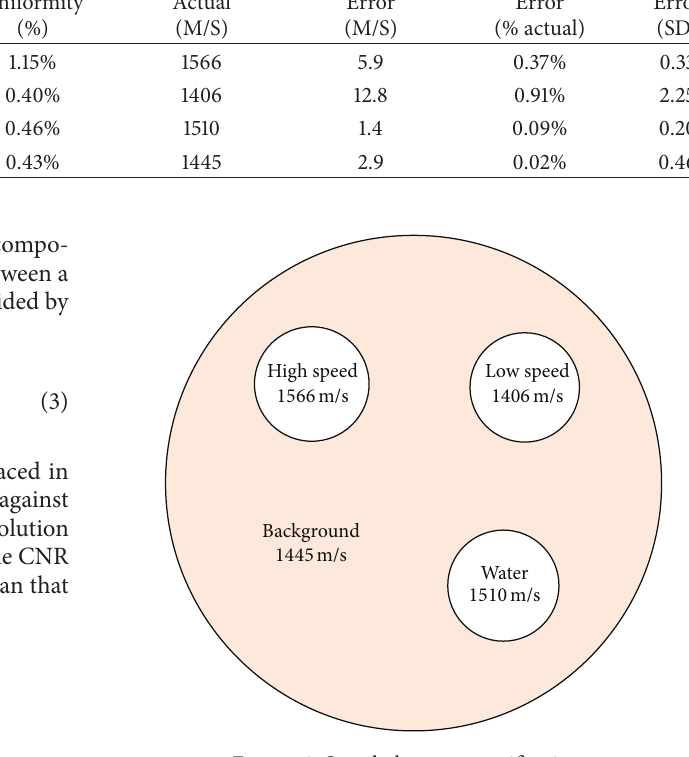
Figure 2: Speed phantom specifications.